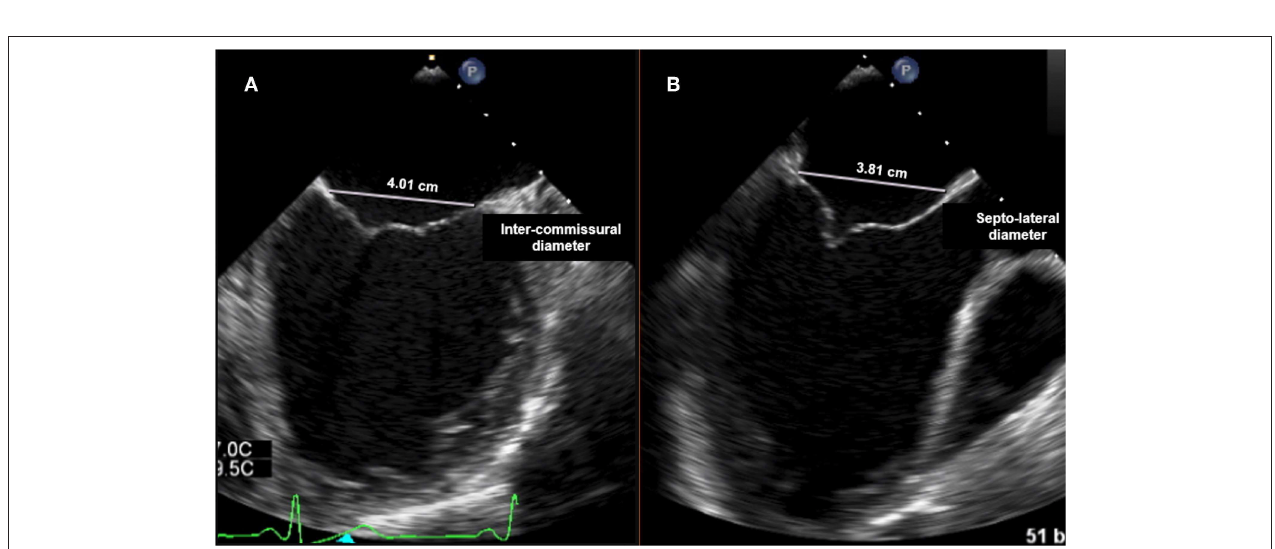
FIGURE 1 | The saddle-shape configuration of the mitral valve. The nonplanar shape is believed to significantly reduce the mechanical strains on the posterior leaflet during systole and optimize force distribution among mitral apparatus.